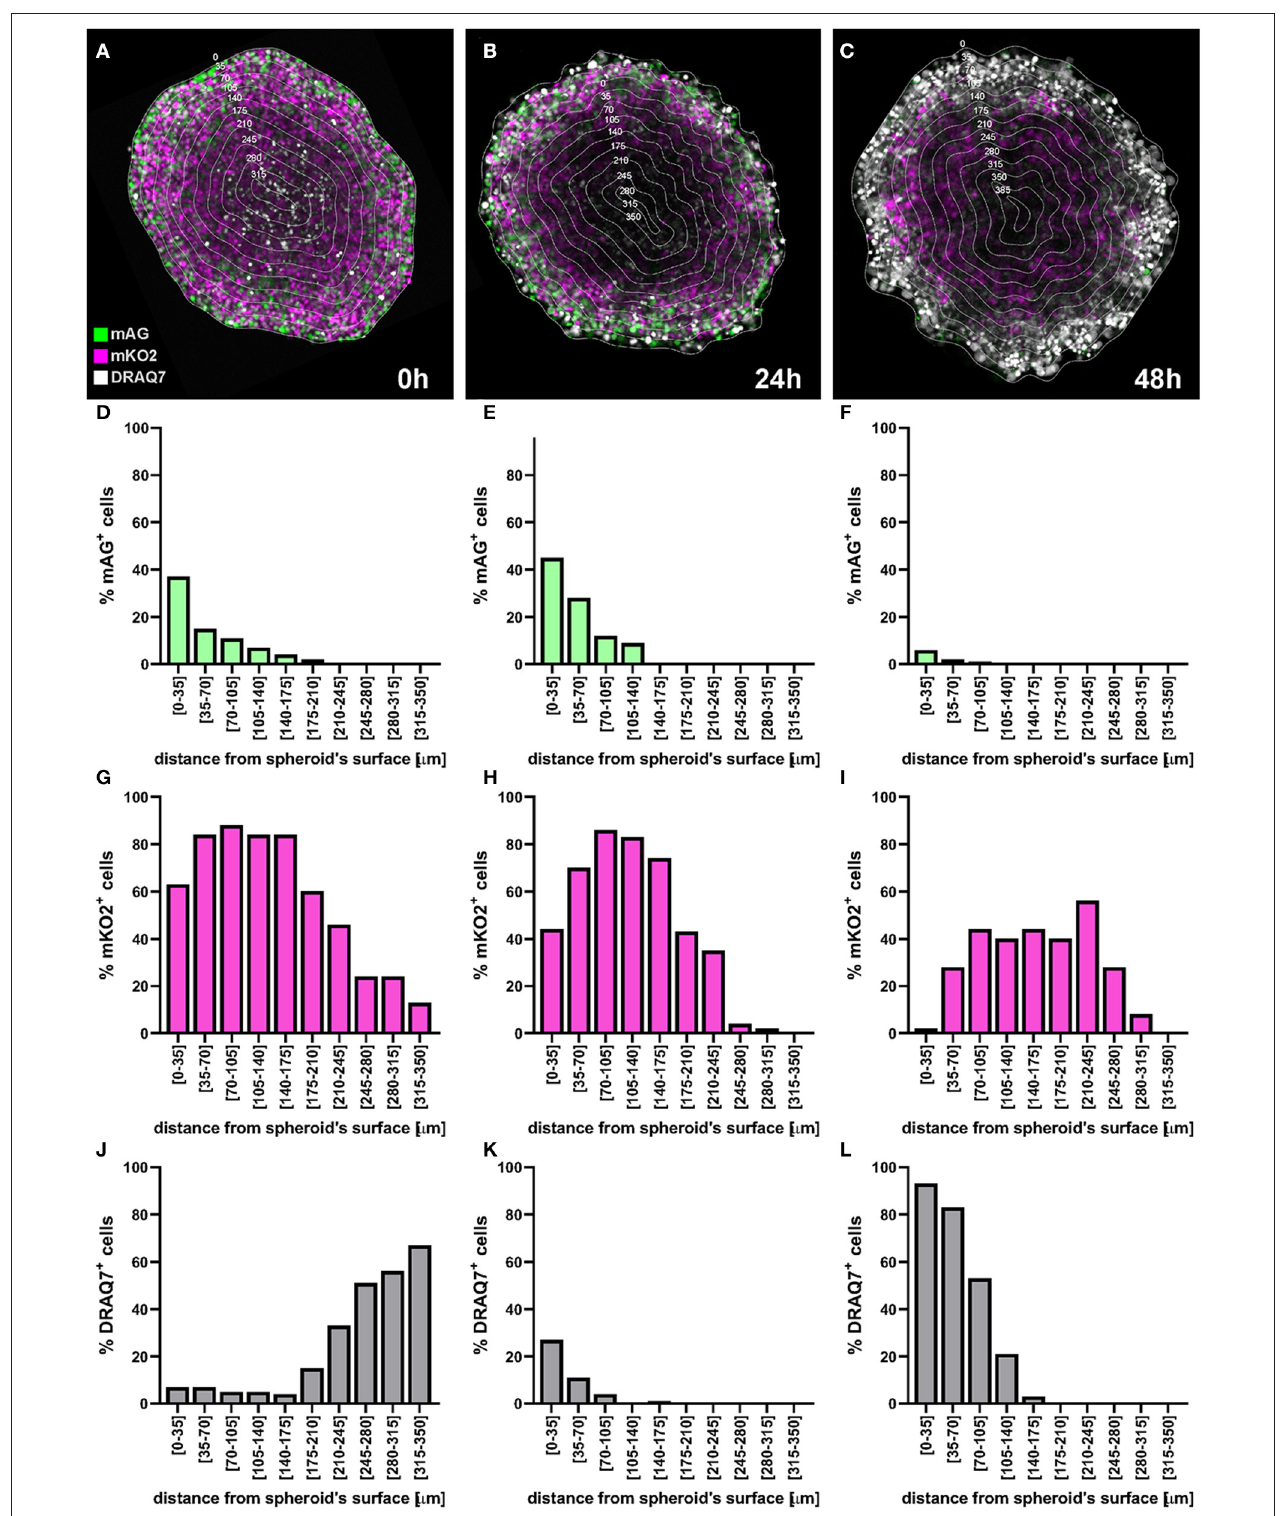
FIGURE 13 | Application example: detection of cell killing by bortezomib. A FUCCI-C8161 melanoma spheroid was incubated with 50nM bortezomib for 48h and a central confocal fluorescence image was taken at 0h (A) , 24h (B) , and 48h (C) . DRAQ7 was added to the culture medium 24h prior to bortezomib addition to a final concentration of 3 µ M. Percentages of mAG + (D–F) , mKO2 + (G–I) and DRAQ7 + (J–L) cells were calculated using an image analysis similar to that applied for the example depicted in Figure 11 and plotted as a function of the distance from the spheroid surface.